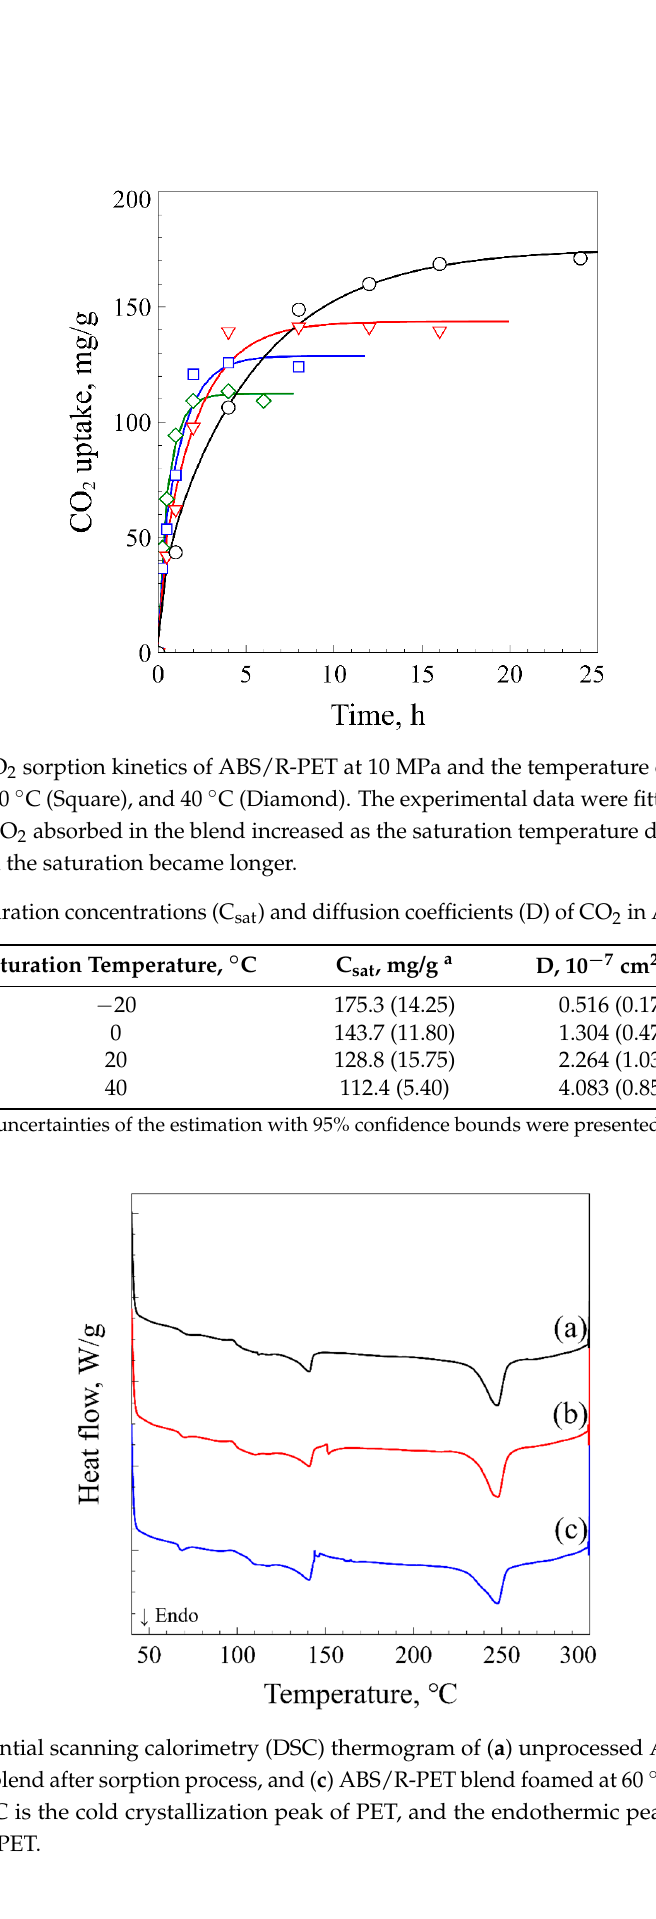
Figure 3. Differential scanning calorimetry (DSC) thermogram of ( a ) unprocessed ABS/R-PET blend, ( b ) ABS/R-PET blend after sorption process, and ( c ) ABS/R-PET blend foamed at 60 ◦ C. The exothermic peak near 150 ◦ C is the cold crystallization peak of PET, and the endothermic peak at 250 ◦ C is the melting peak of